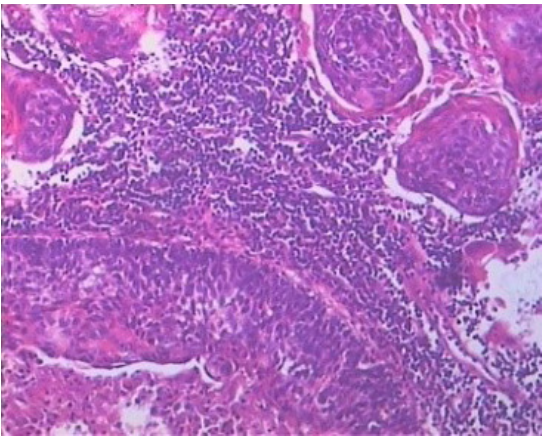
Fig. 8. Pathology of inguinal lymph nodes (HE,